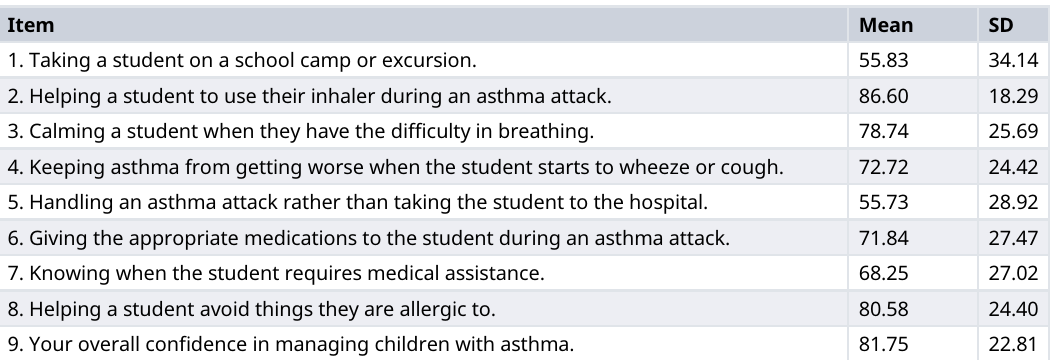
Table 3. Teachers ’ confidence scores regarding the management of asthmatic children (N = 103). 24